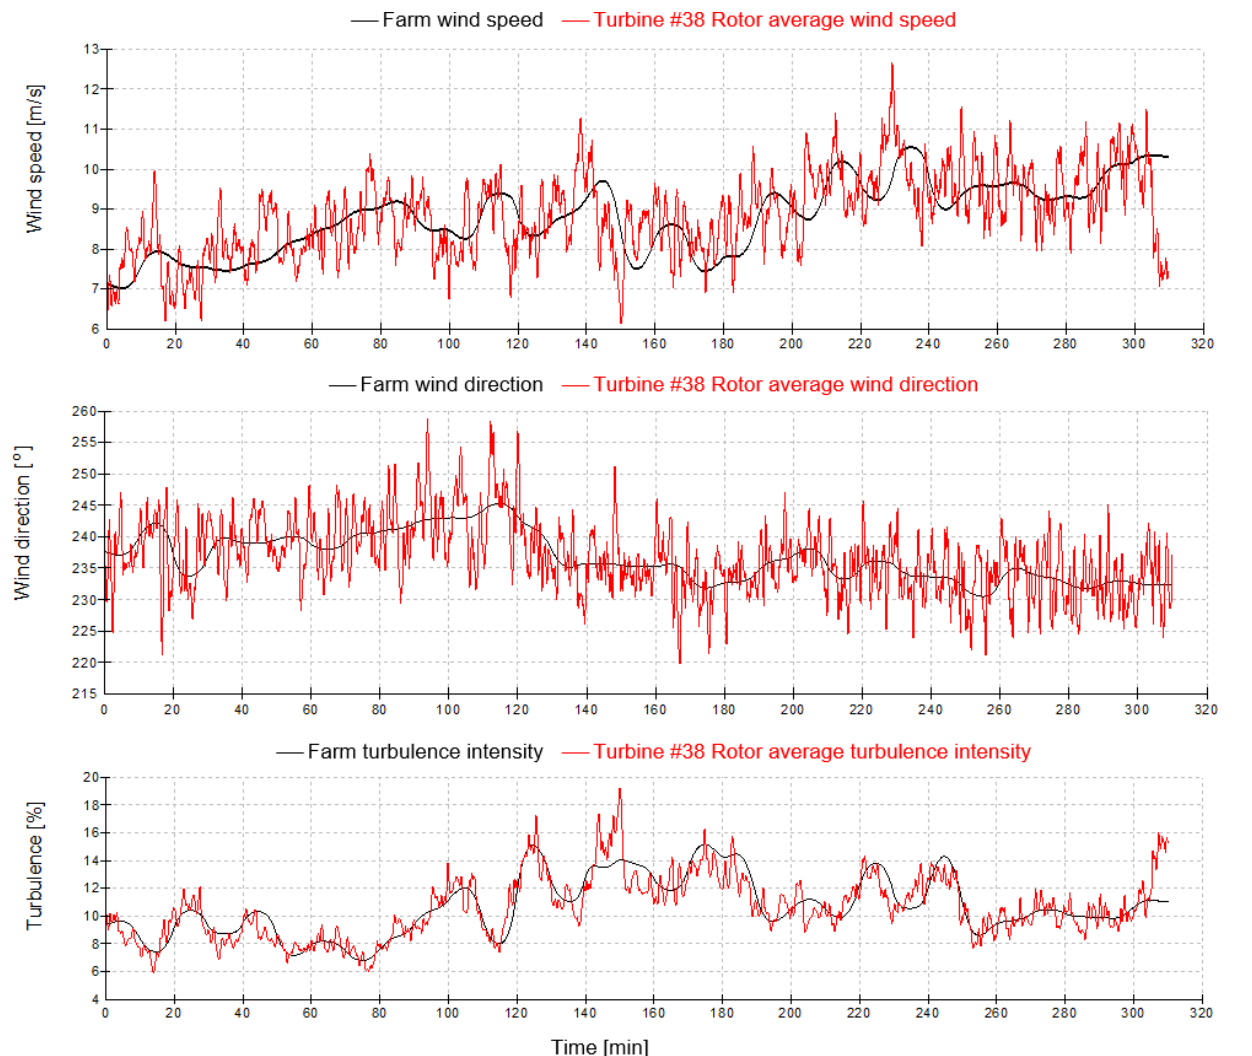
Figure 7. Wind conditions for the initial simulations. The black line represents the smoothed 10min mast data and is assumed to apply at a point halfway down the row of turbines. The red line shows conditions from the simulated wind field at the turbine no. 38 rotor.